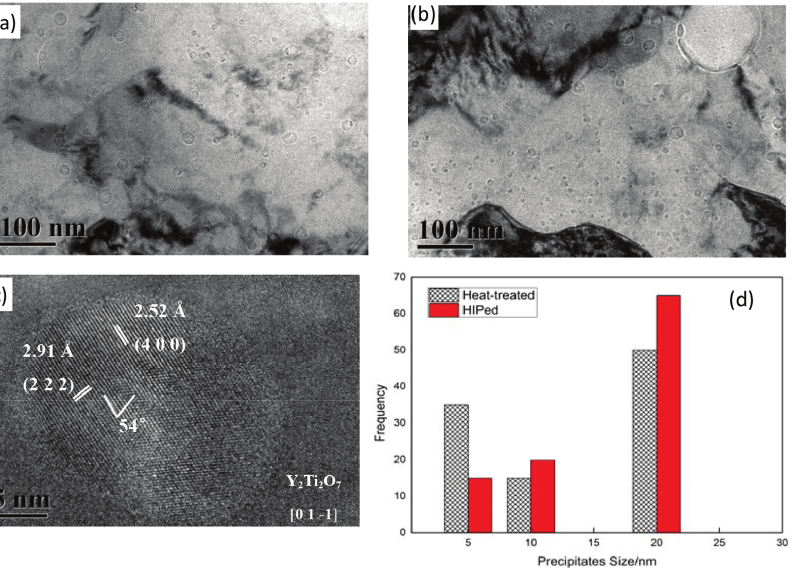
Figure 2: (a), (b) TEM images of precipitates of HIPed and heat-treated ODS steels, (c) HRTEM of the pyrochlore structure Y 2 Ti 2 O 7 , (d) Precipitate size distribution in ODS steels with different states.